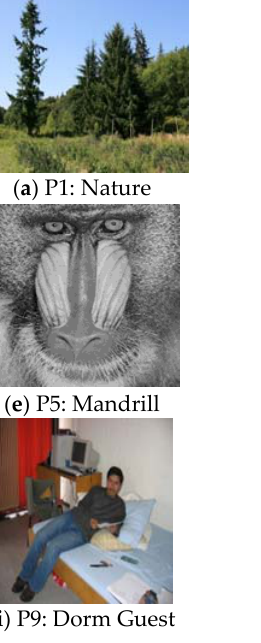
Figure 4. Cover images used in the experiment.